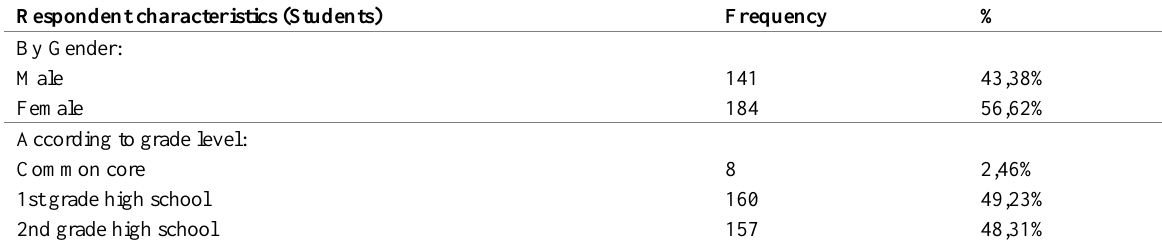
Table 1: Respondent characteristics (Students)